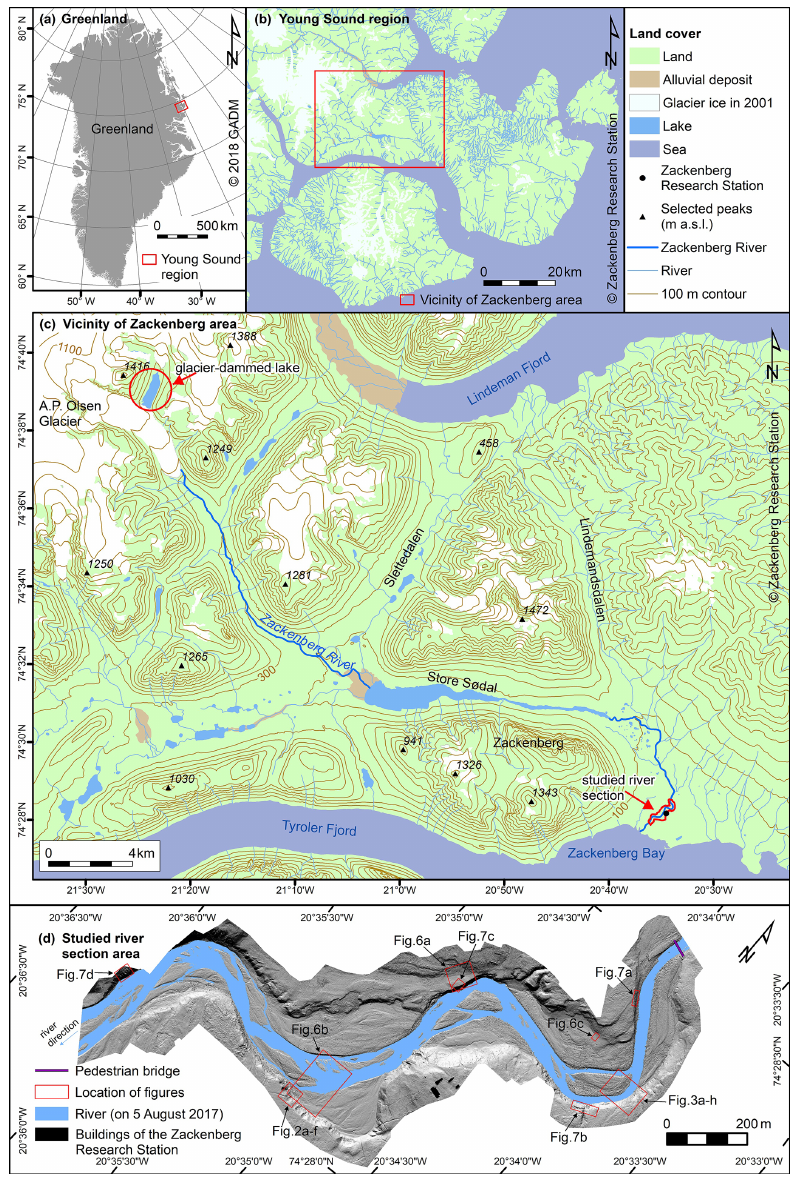
Figure 1. Location of the study area (reprinted from Tomczyk et al., 2020, with permission from Elsevier, copyright 2020). Panel (d) shows survey area with extent of Figs. 2, 3, 6, and 7 indicated with